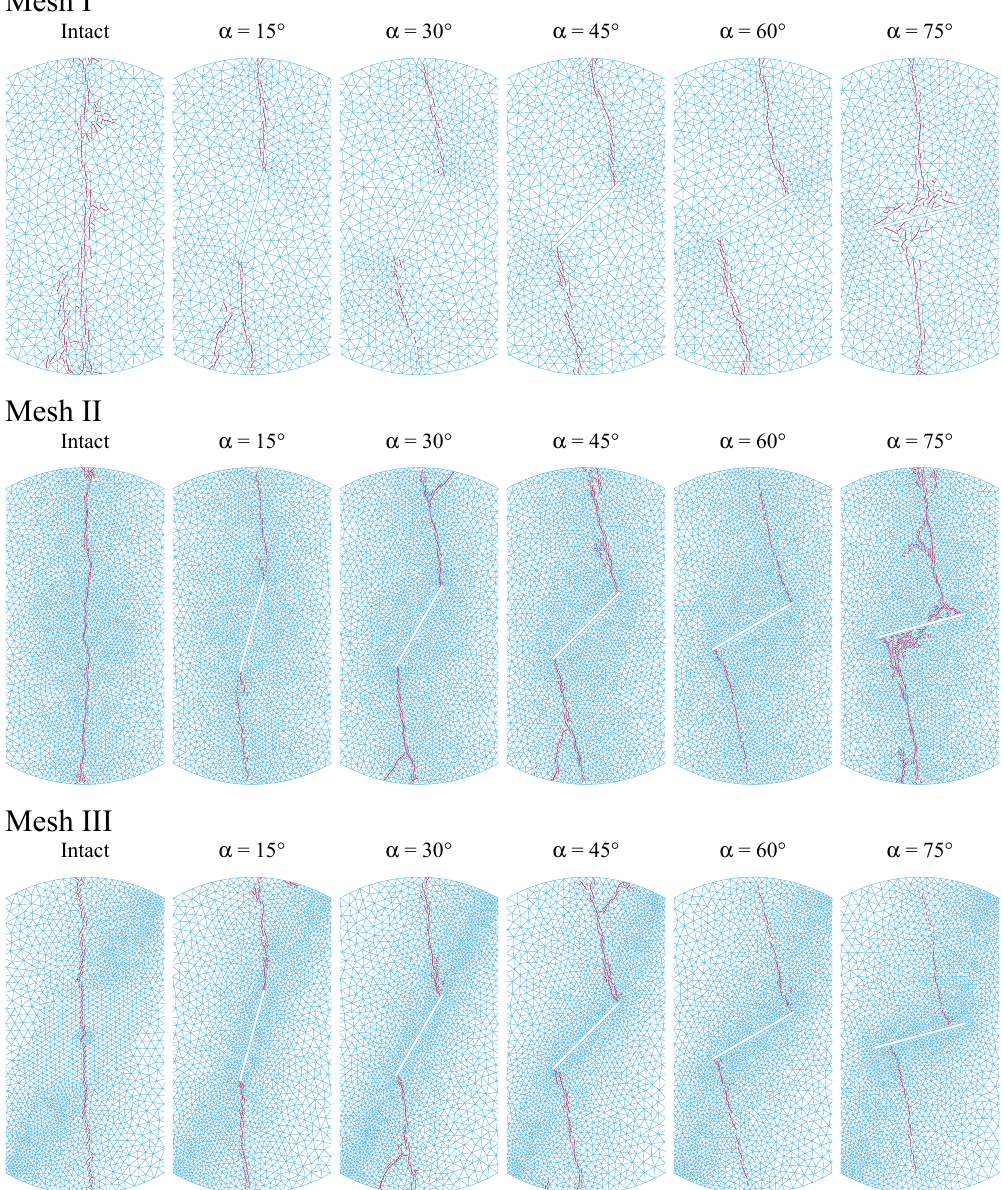
Figure 3. Brazilian disk tests: crack paths regarding different inclined angle α and